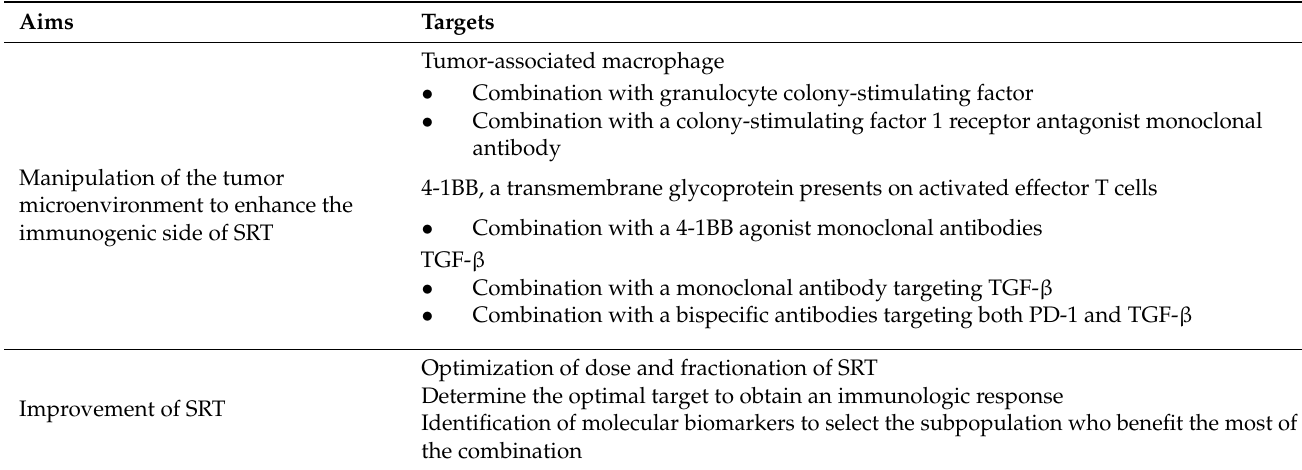
Table 3. Perspectives of the combination immune checkpoint inhibitor and stereotactic radiation therapy